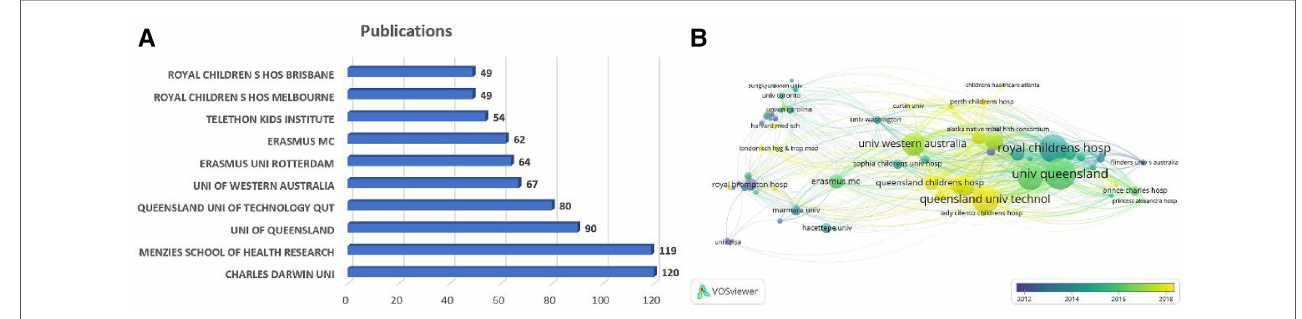
FIGURE 4 Analysis of institutions related to pediatric bronchiectasis between 2003 and 2022. ( A ) Bar chart of the number of publications in the top 10 institutions. ( B ) Cooperation network map of institutions. Node size represents the number of publications, link represents the cooperation relationship, and color represents the average cooperation year.